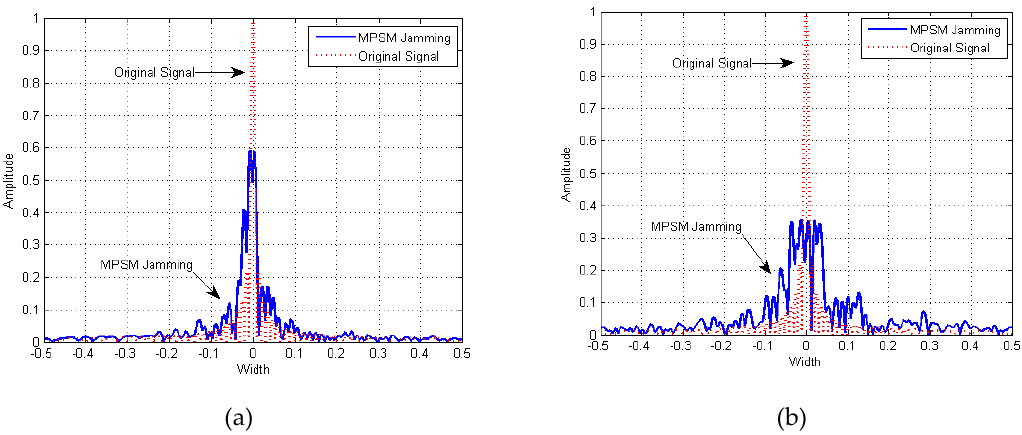
Figure 16. MPSM jamming with optimized section situation: ( a ) four sections and ( b ) 16 sections. Table 9. Results of MPSM jamming in Figure 16.